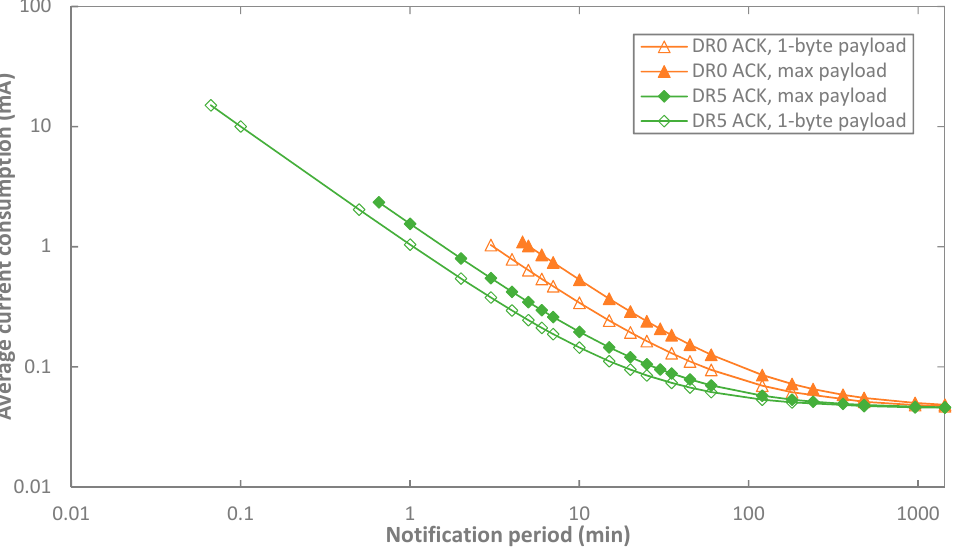
Figure 10. Comparison of the end-device average current consumption with 1-byte and maximum-sized frame payload in acknowledged transmission, as a function of T Notif , and for different DR settings, for BER = 0 and p coll = 0. Only DR0 and DR5 are shown in the figure for the sake of illustration clarity.